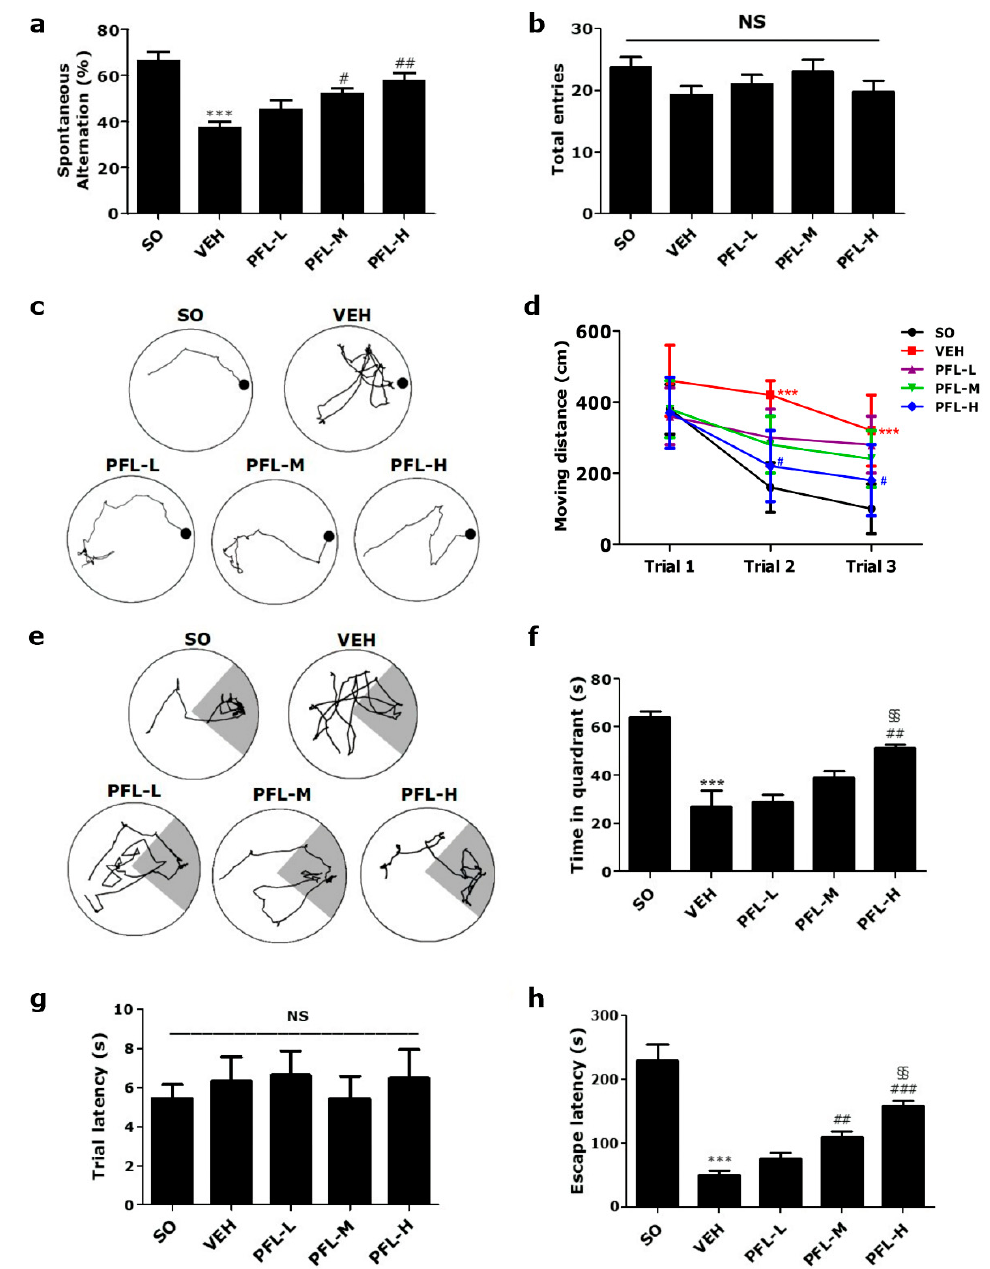
Figure 3. Effects of PFL on memory deficits in VaD rats. ( a ) Spontaneous alternation and ( b ) total arm entries of different groups were measured using the Y-maze test. Using the Barnes maze trial test session, ( c ) tracking plots made at the 3rd trial day and ( d ) time-dependent changes in the moved distance to the platform of different groups were obtained. Using the Barnes maze probe test session, ( e ) tracking plots and ( f ) time spent in the target quadrant of different groups were obtained. In the tracking plots, the locations of the platform and target quadrant are indicated as a black circle and dark area, respectively. ( g ) Trial latency and ( h ) escape latency in different groups were measured using the passive avoidance test. In all graphs, values are presented as the mean ± SEM (*** p < 0.001 vs. SO; # p < 0.05, ## p < 0.01, and ### p < 0.001 vs. VEH; §§ p < 0.01 vs. PFL-L; and NS, statistically not